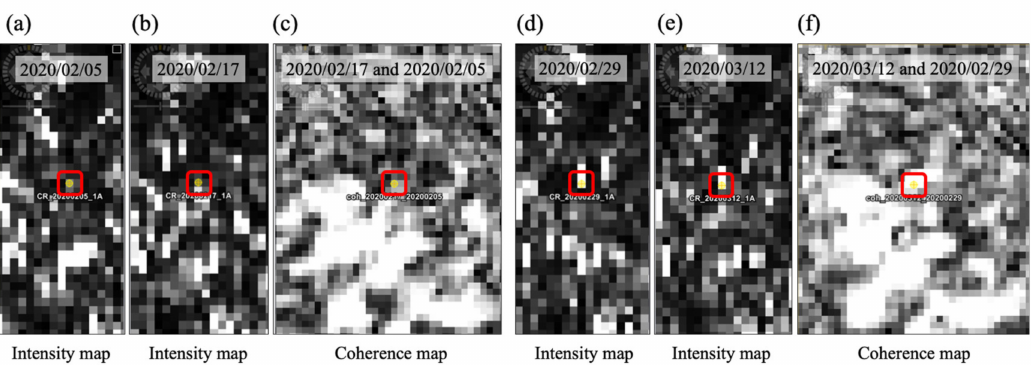
Figure 8. The intensity and coherence maps of the SAR images. The intensity and coherence values were enhanced significantly after the corner reflector was placed. The intensity maps of the SAR images acquired before the placement of corner reflector are ( a ) 05 February 2020 and ( b ) 17 February 2020. ( c ) The coherence map calculated between the SAR images derived on 05 February 2020 and 16 February 2020. The intensity maps of the SAR images acquired after the placement of corner reflector are ( d ) 29 February 2020 and ( e ) 12 March 2020. ( f ) The coherence map calculated between the SAR images derived on 29 February 2020 and 12 March 2020. The yellow circle indicates the position of the corner reflector.